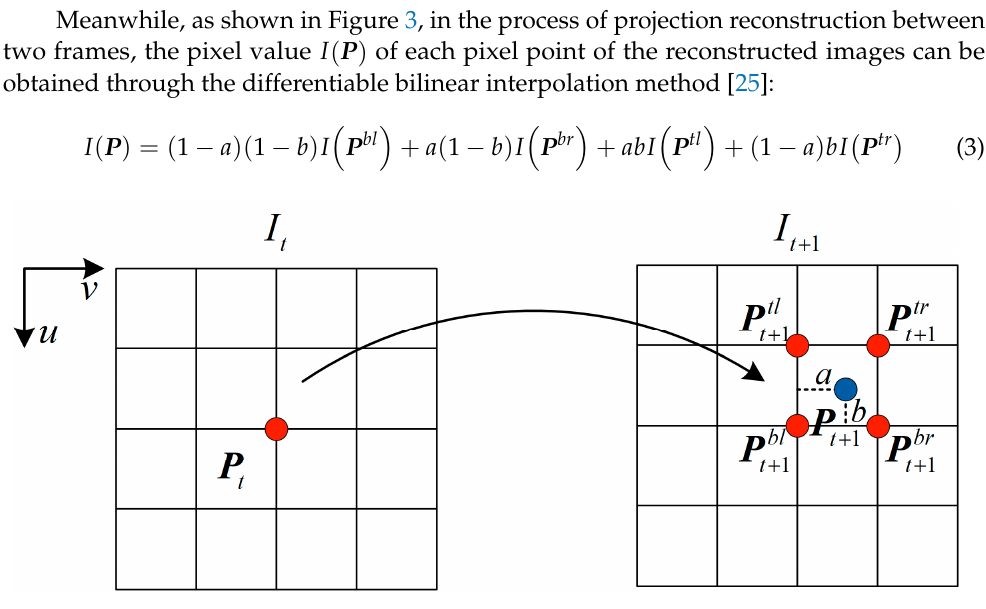
Figure 3. Diagram of bilinear interpolation process.